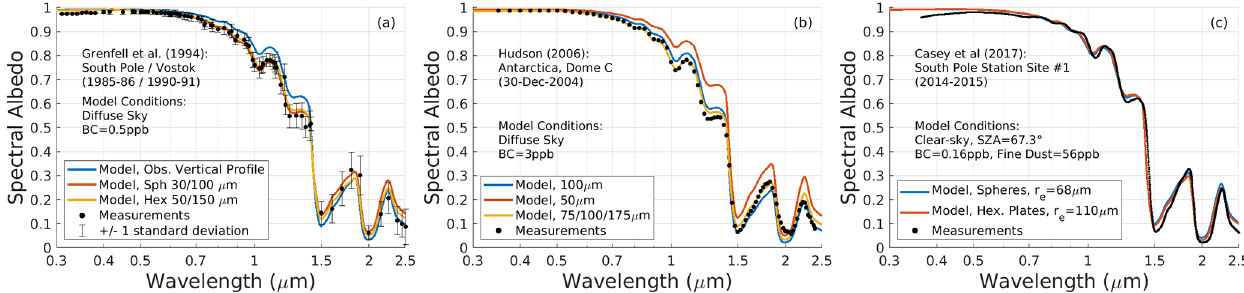
Figure 9. Comparison of modeled spectral snow albedo with measurements from Grenfell et al. (1994) (a) , Hudson et al. (2006) (b) , and Casey et al. (2017) (c) of very clean snow from Antarctica. The environmental conditions and model parameters for each setting are listed in the panels and described in Sect.